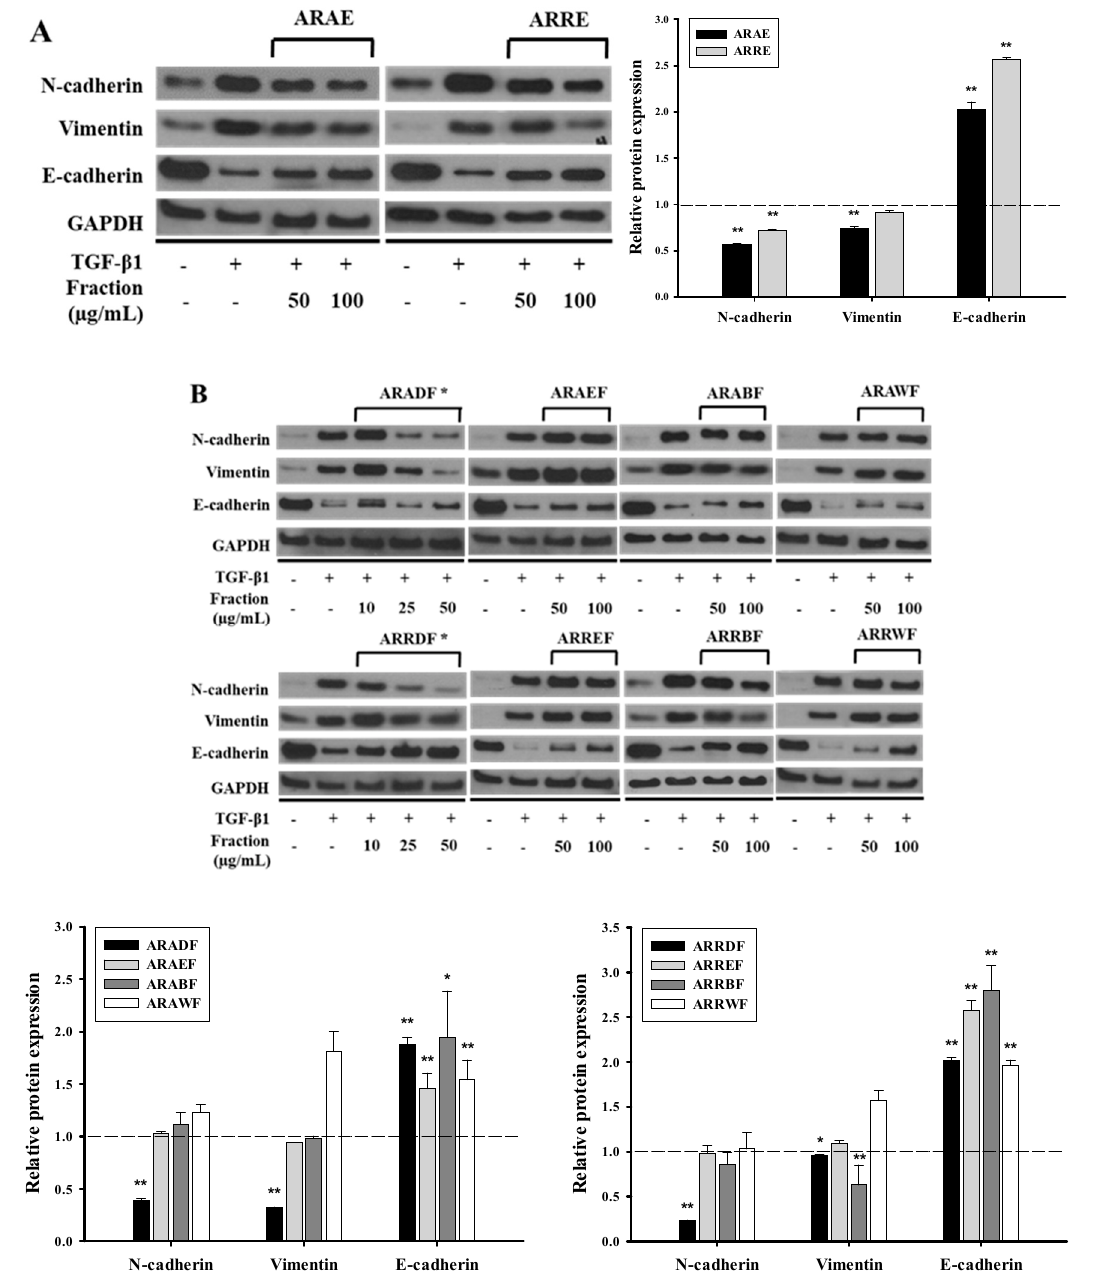
Figure 3. Inhibitory effect of fractions derived from Astilbe rubra on TGF- β 1-induced epithelial-to-mesenchymal (EMT). A549 cells were co-treated with TGF- β 1 (2 ng/mL) along with the ethanol extracts ( A ) and the fractionated samples ( B ) of A. rubra for 48 h. All samples, except for the CH 2 Cl 2 fractions, were treated at concentrations of 50 and 100 μ g/mL. The CH 2 Cl 2 fractions were treated at concentrations of 10, 25, and 50 μ g/mL. Protein expression was investigated using Western blot analysis, with GAPDH used as a loading control. * shows the strongest inhibitory effect on the TGF- β 1-induced EMT of all the fractions tested. The bar graphs represent the quantification of the Western blots using ImageJ. * p < 0.05, ** p < 0.01 vs. the TGF- β 1-treated group (dot-line). ARAE, EtOH extract of the aerial part; ARADF, CH 2 Cl 2 extract of the ARAE; ARAEF, EtOAc extract of the ARAE; ARABF, n-BuOH extract of the ARAE; ARAWF, water extract of the ARAE; ARRE, EtOH extract of the rhizome; ARRDF, CH 2 Cl 2 extract of the ARRE; ARREF, EtOAc extract of the ARRE; ARRBF, n-BuOH extract of the ARRE; and ARRWF, water extract of the ARRE. 2.3. β -Peltoboykinolic Acid Attenuates TGF- β 1-Induced EMT